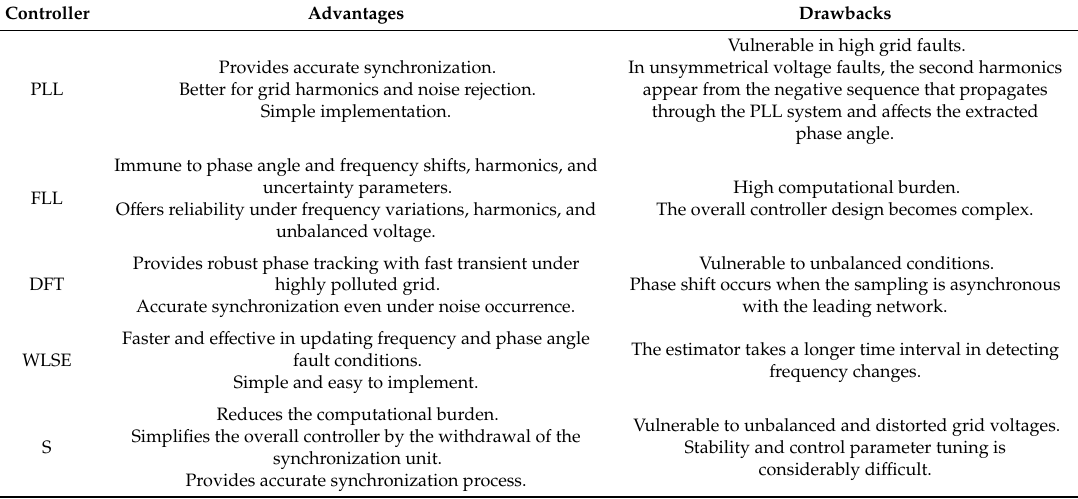
Table 4. The advantages and drawbacks of the grid synchronization